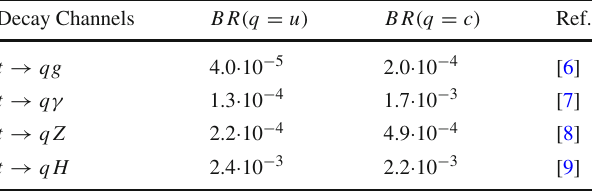
Table1 Thecurrentexperimental95%C.L.upperlimitsonthebranch- ing fractions of the top quark FCNC decays obtained at the LHC exper- iments Decay Channels